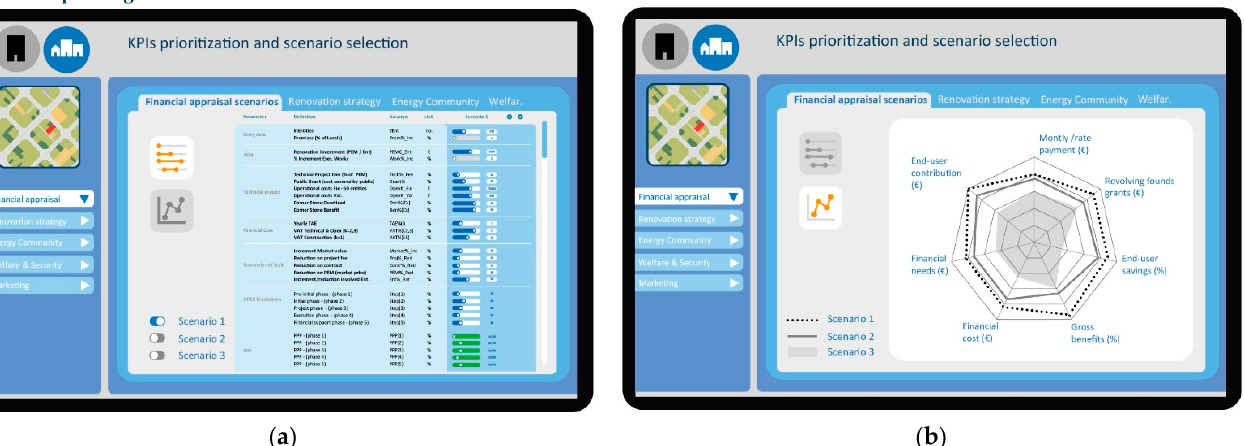
Figure 4. Extract of the PEDRERA model approach, expected visualization in the urbanZEB tool. Demand aggregation menu with: ( a ) the renovation measures input; ( b ) the integration of aggregated and gathered data for the cost analysis. Source: authors.